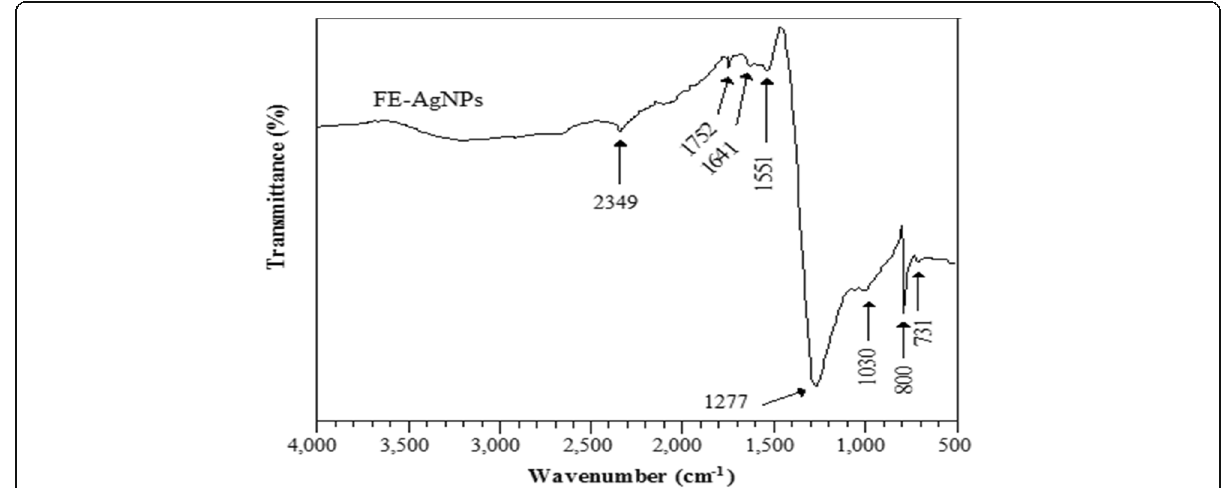
Fig. 2 Fourier transform infrared spectroscopy (FTIR) spectra of silver nanoparticles synthesized from F. exasperata extract